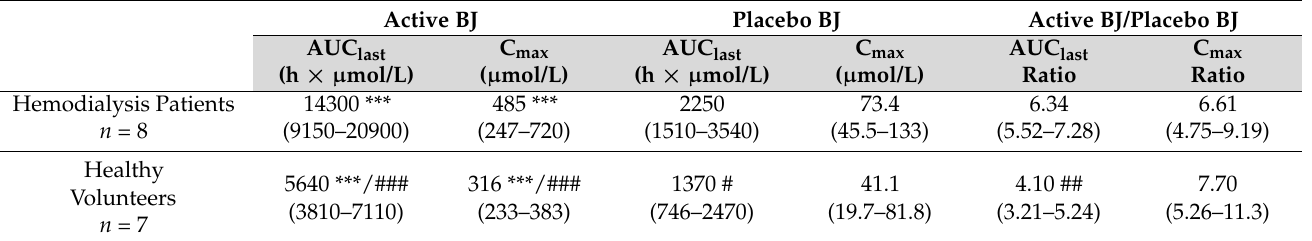
Legend: Plasma nitrate AUC last , C max , in HD patients and in healthy volunteers after 70 mL concentrated BJ (active) or placebo BJ ingestion. Data are presented as geometric mean values. In brackets: Range for columns with Active and Placebo, and 90% Confidence Interval of AUC ratio of geometric mean for columns with Active/Placebo Ratio. Student’s paired t-test: *** p < 0.001 as compared with placebo. Student’s t-test: # p < 0.05; ## p < 0.01; ### p < 0.001 as compared with HD patients . Table 5. Kinetic analysis of plasma nitrite after single ingestion of nitrate-enriched (Active) and nitrate-depleted (Placebo) beetroot juice (BJ) in hemodialysis patients and in healthy volunteers. Active BJ Placebo